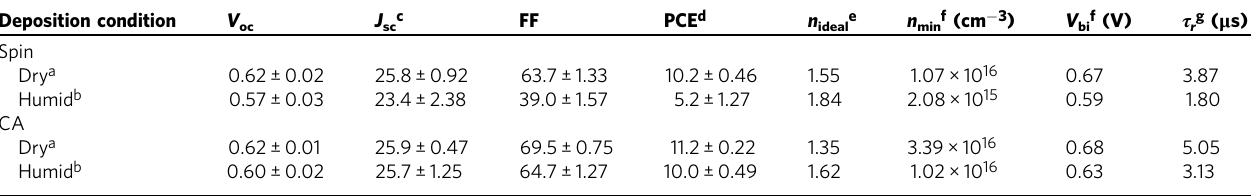
Table 2 Summarized photovoltaic parameters for the CQD solar cells prepared under different conditions. Deposition